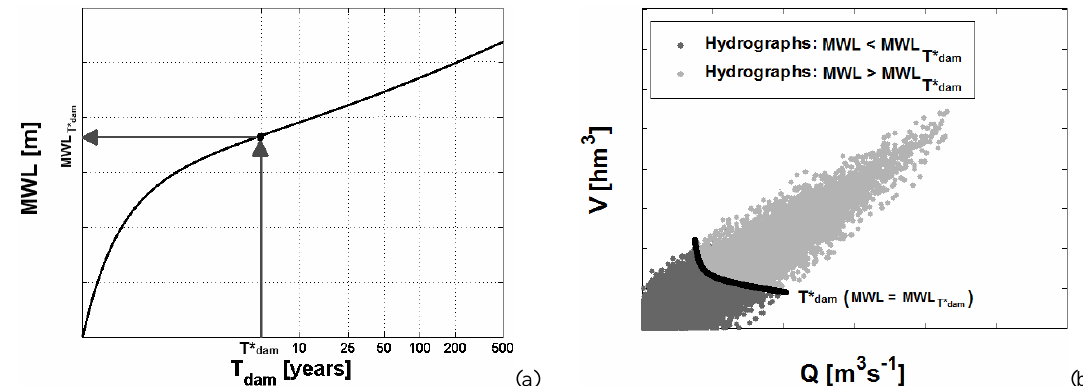
Fig. 1. Procedure to obtain the routed return period curve that represent the risk of dam overtopping ( T dam ). (a) Estimation of the MWL for the given return period T ∗ (MWL T ∗ ) from the frequency curve of MWL. (b) Estimation of the routed return period curve by selecting the hydrographs that reach a given water level equal to MWL T ∗ .